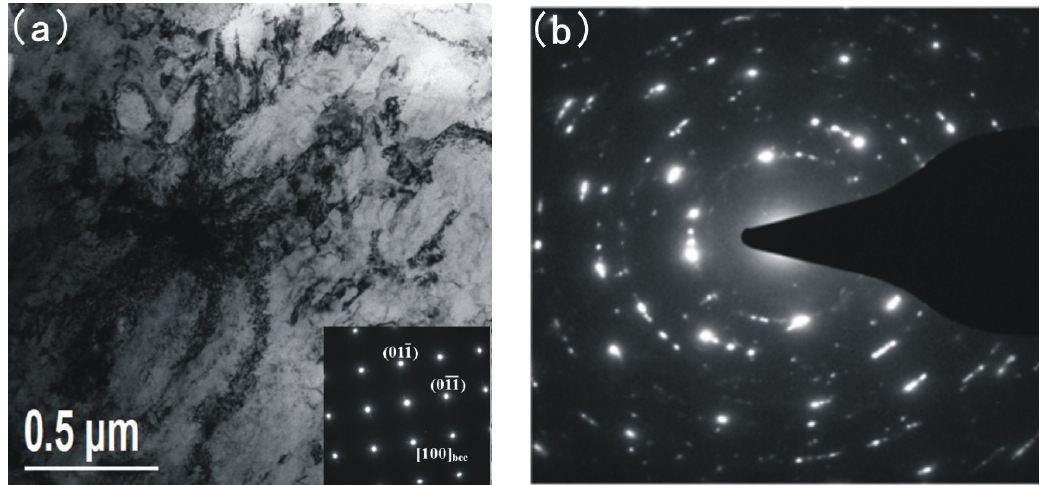
Figure 5. Transmission electron microscopy (TEM) and corresponding diffraction patterns of base metal; ( a ) lath martensite matrix and precipitates; ( b ) corresponding diffraction patterns of ( a ).